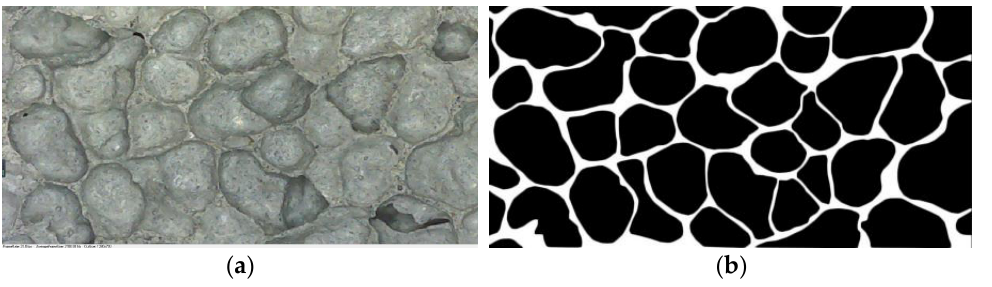
Figure 10. Pore cross-sectional image of 4% of foam dosing: ( a ) original image, ( b ) cross-sectional